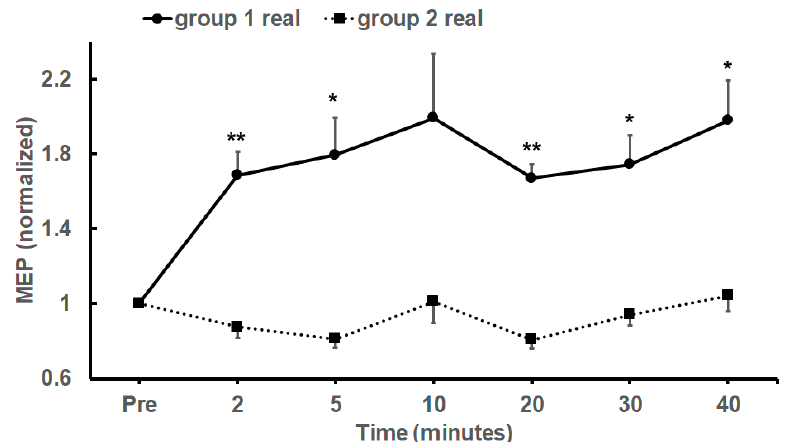
Figure 3. Normalized Mean MEP (± SEM) amplitudes recorded from of groups 1 (circles, uninterrupted line) and 2 (squares, dotted line) before and after 20 minutes of anodal tDCS. Post-hoc significance results are indicated by * ( p < 0.05) or ** ( p < 0.01).